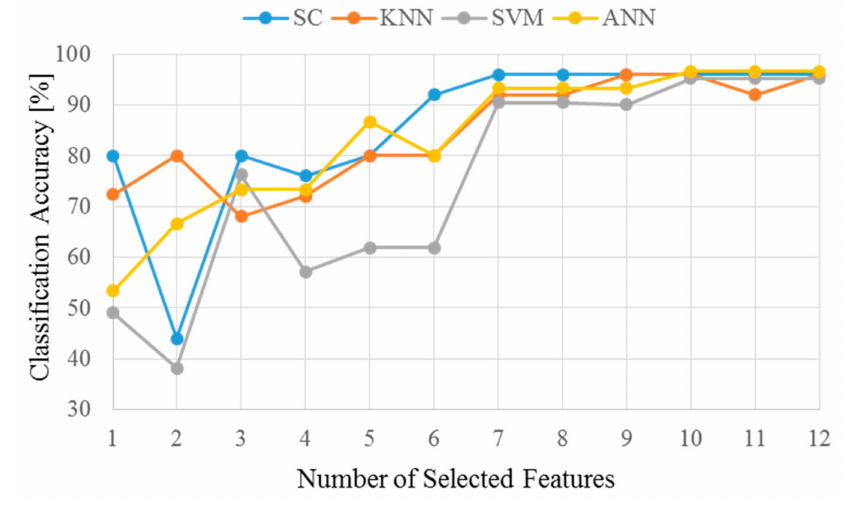
Figure 8. Single fault classification results. Table 1. Classification Accuracy for a Single